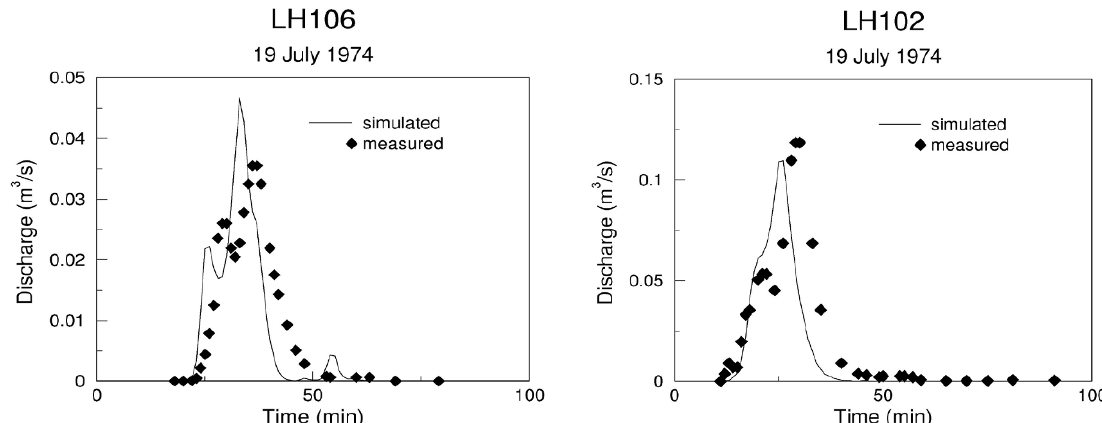
Figure 4. Measured and simulated hydrographs for the nested sub-watersheds LH106 and LH102 for the 19 July 1974